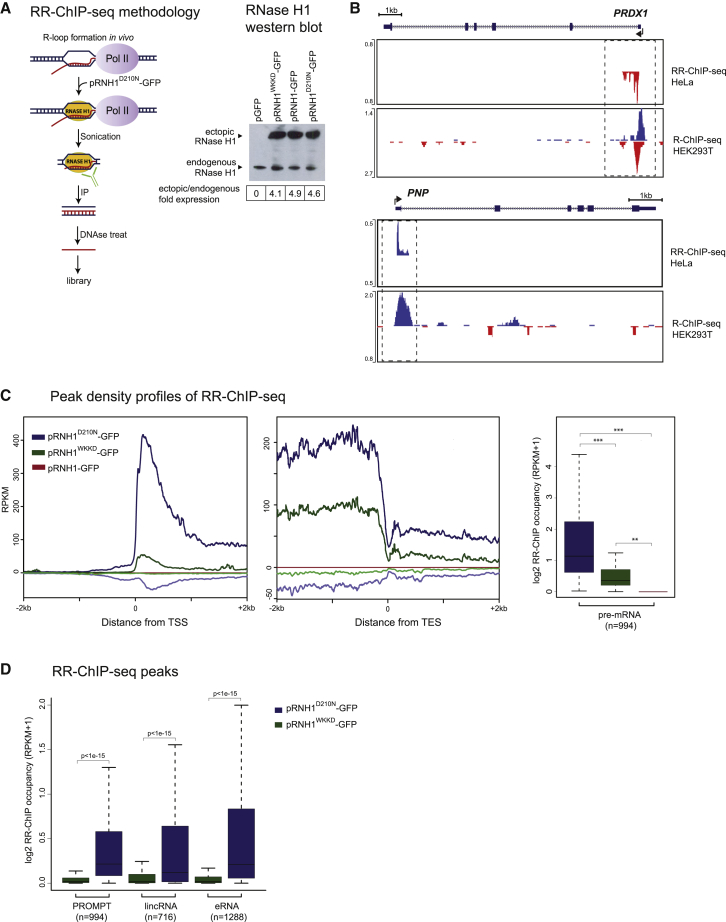
Genomic Analysis of R-Loop Distribution(A) Schematic of RR-ChIP-seq methodology (left panel). Hybrid interaction with catalytic mutant D210N RNase H1 is used to create a directional RNA library. Right panel shows expression levels of GFP-tagged ectopic RNase H1 (pRNH1-GFP) and mutants by western blot. WKKD is a non-binding catalytic mutant (W43A, K59A, K60A, and D210N).(B) RR-ChIP-seq and R-ChIP-seq peak profiles for PRDX1 and PNP.(C) Meta-analysis (left and middle panels) and boxplots (far right panel) of averaged RR-ChIP-seq signals of protein-coding genes across ±2 kb genomic region flanking TSS and TES regions for pRNH1 D210N and WKKD mutants and wild-type RNase H1 (p = 1.5e-09, Kruskal-Wallis test). Notably, almost all RR-ChIP-seq peaks disappear with the wild-type RNase H1 condition.(D) Boxplots of RR-ChIP-seq signal over various genomic locations for D210N and WKKD mutants for PROMPTs (3 kb from TSS), pre-mRNA (whole annotated gene), lincRNA (TSS to TES), and eRNA (2 kb from center).